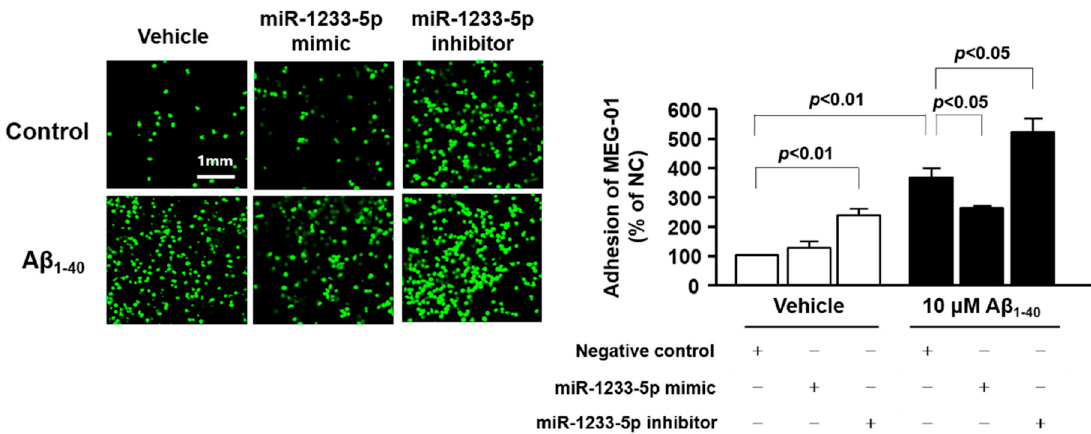
Figure 5. Role of miR-1233-5p in the adhesion of transfected MEG-01 cells. miR-1233-5p was overexpressed or downregulated using a specific mimic or inhibitor in MEG-01 cells for 24 h, and the cells were harvested for adhesion assay. Adhesion of transfected MEG-01 cells in the absence and presence of 10 μ M A β 1-40 for 1 h on fibronectin-coated coverslips was presented and quantified. Data are mean ± SEM of five experiments.